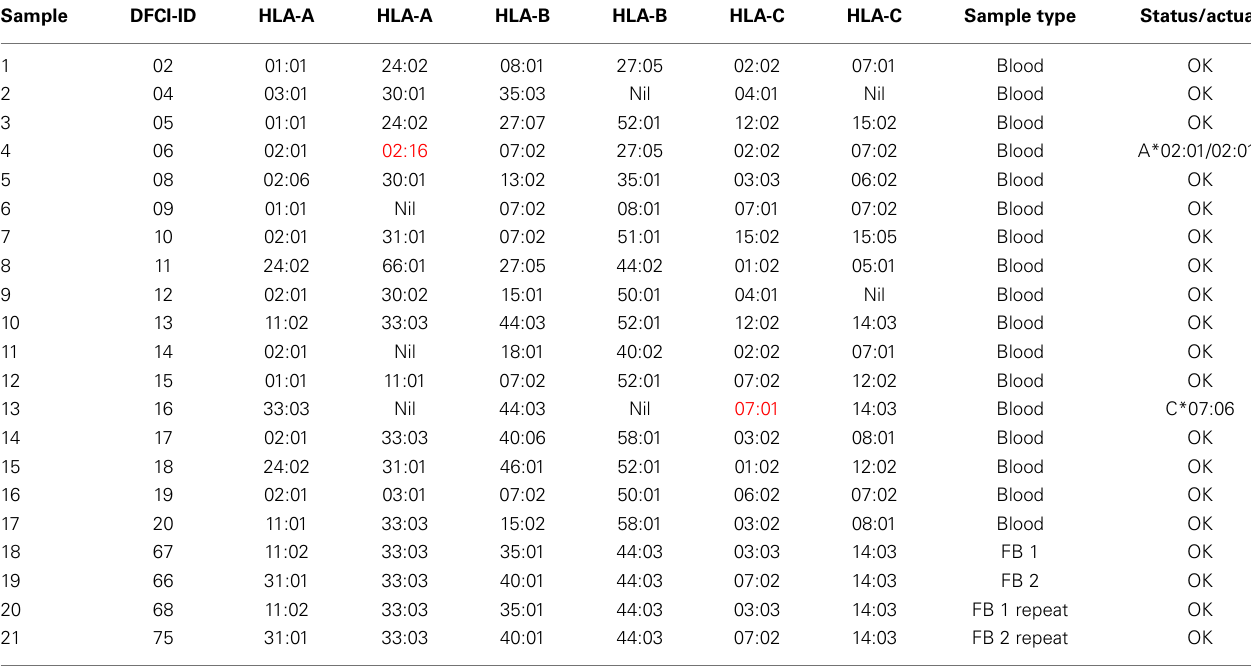
Table 3 | Blood samples used in this study